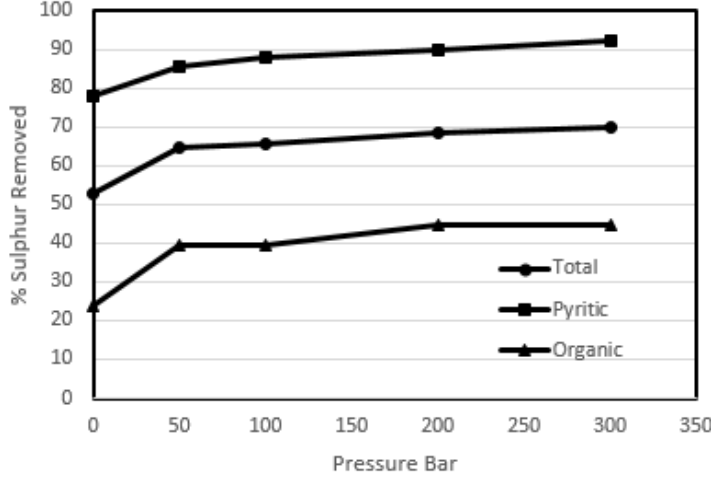
Figure 2. Effect of pressure on total, pyritic and organic sulphur removal.